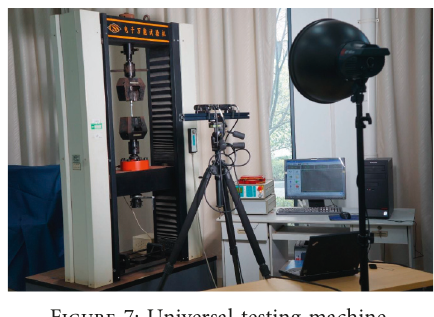
Figure 7: Universal testing